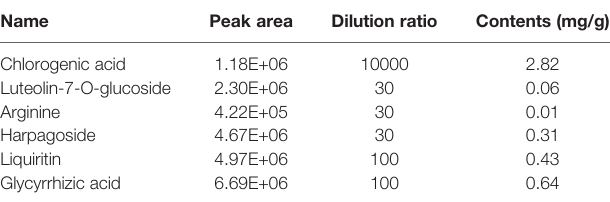
TABLE 3 | The quanti fi cation results of six components in